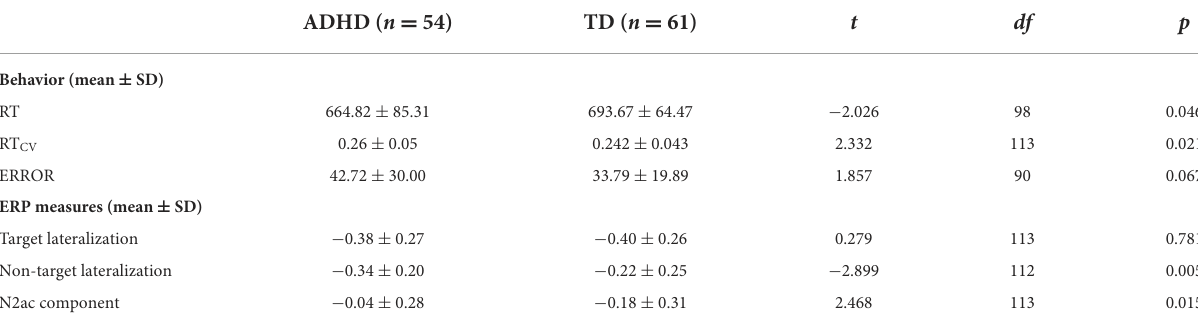
TABLE 2 Group differences in behavioral performance and ERP measures in the auditory selective attention